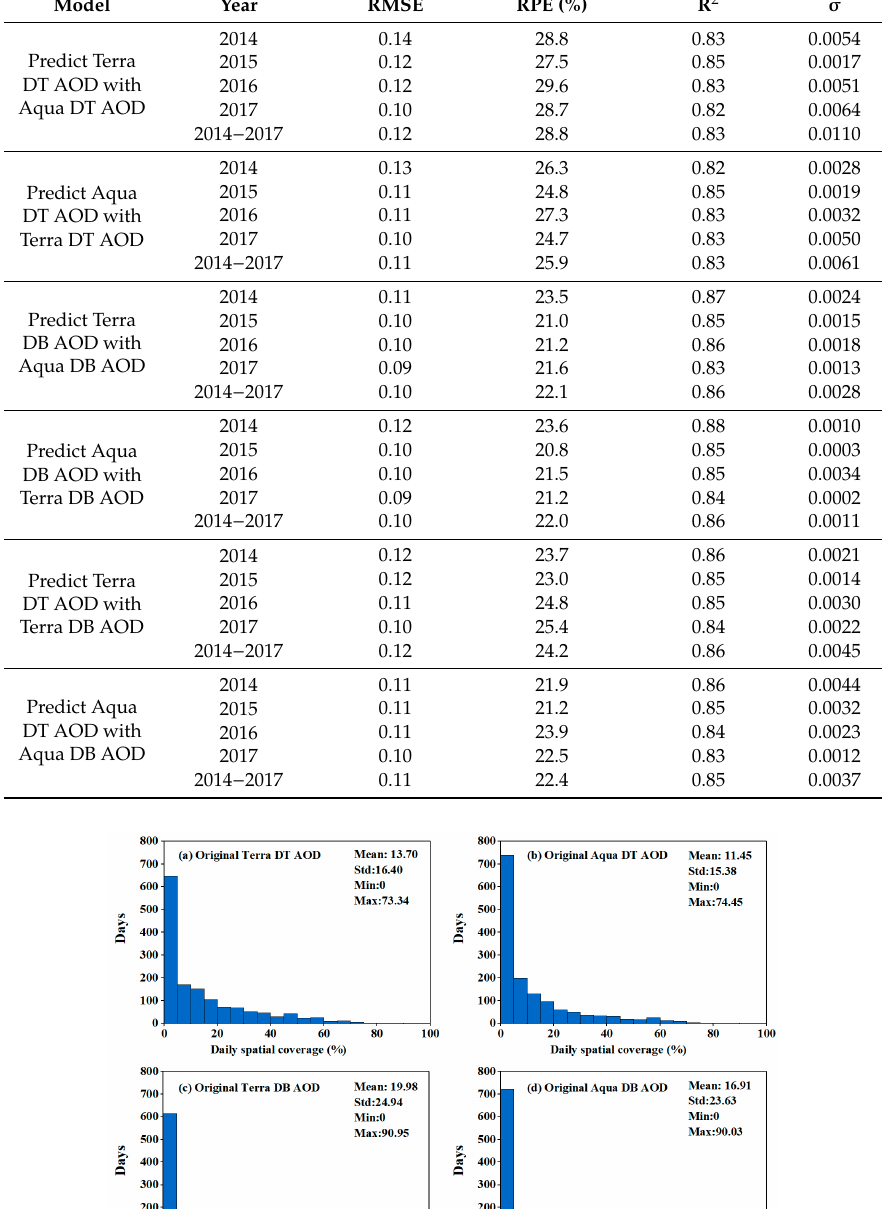
Table A4. Predictive performance of the linear regression models for missing AOD data and standard deviation of the predicted AOD values (10-fold cross-validation).